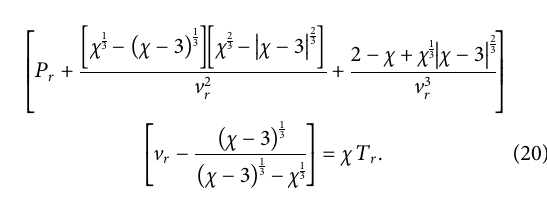
Figure 2 is the diagram of a spinodal curve (8) for the choice of n = 4, a = 0.99, and χ = 3.4556 as for nitrogen (N 2 ). It follows from (18) b = 0.5009 and subsequently (12) fi xes s , t . The curve con fi rms theanticipatedtwoadjacentcriticalpointsat a =0.99and1.00.Spinodal curves for other molecules can be obtained by the same method.